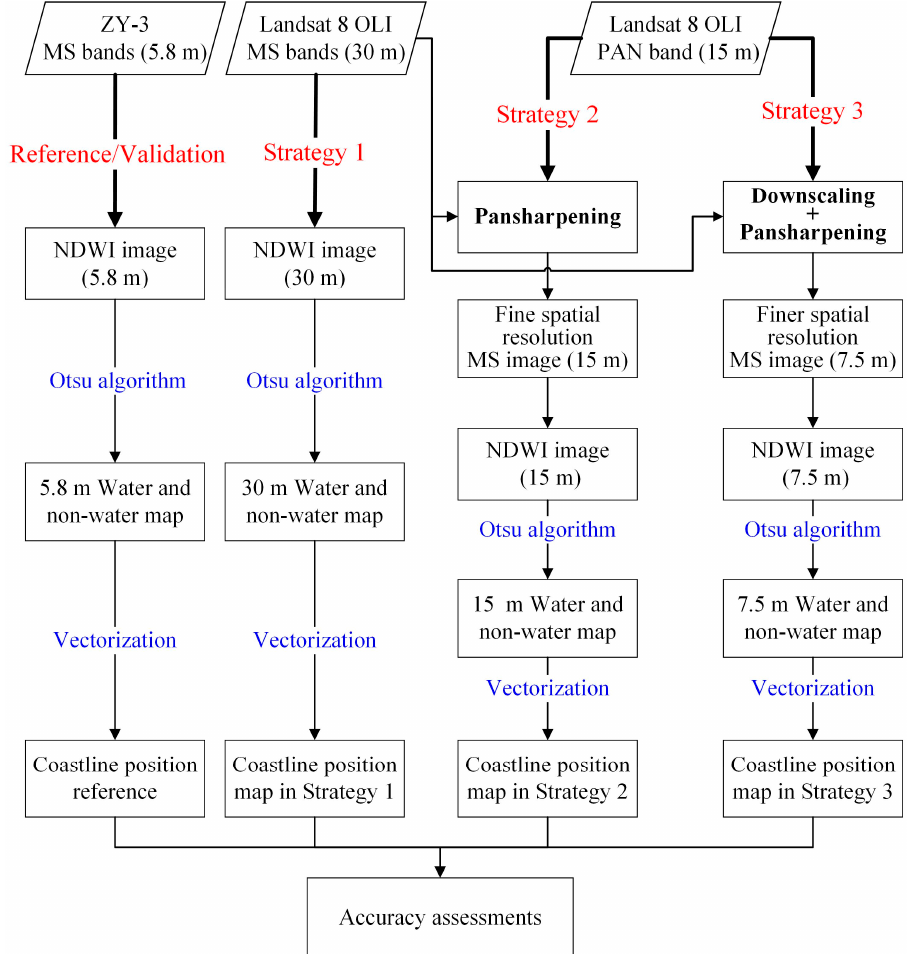
Figure 2. Flowchart of coastline extraction with three strategies.